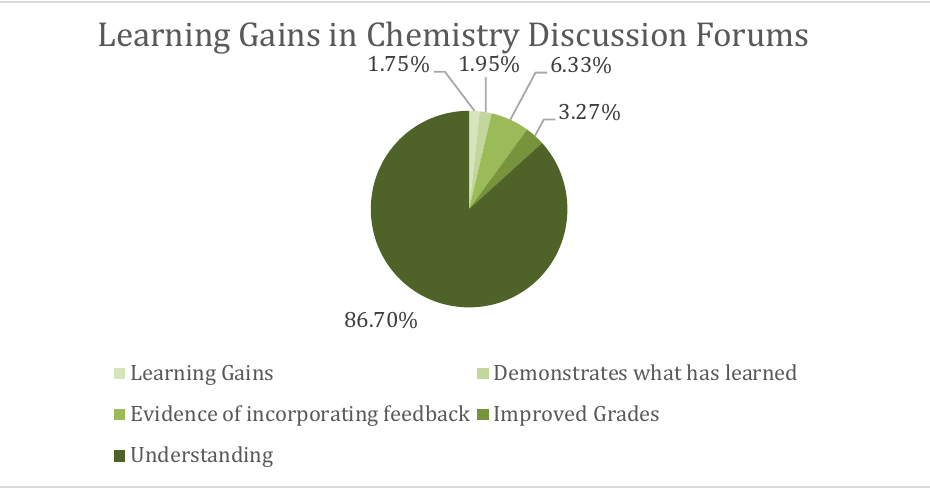
Figure 3. Coding to learning gains in Chemistry discussion forums.